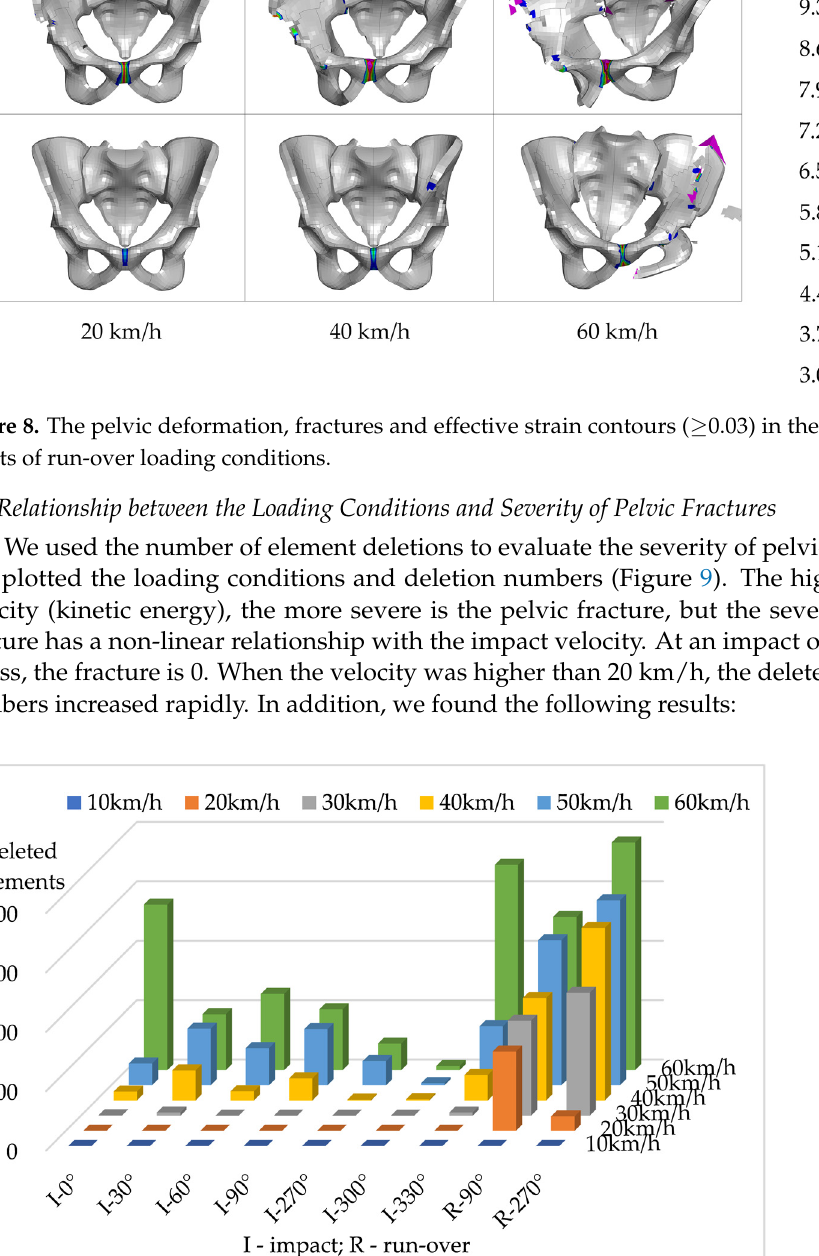
Figure 8. The pelvic deformation, fractures and effective strain contours ( ≥ 0.03) in the simulation results of run-over loading conditions.